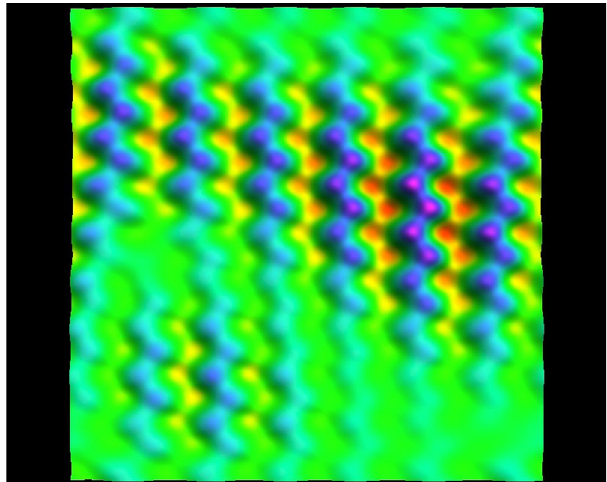
FIG. 3. The u field at t ¼ 300 for the same run as Fig. 1. y